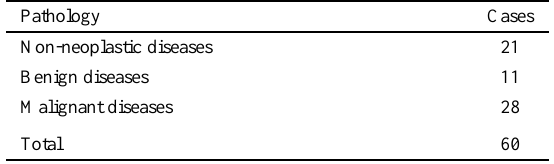
Case composition for the frozen sections set